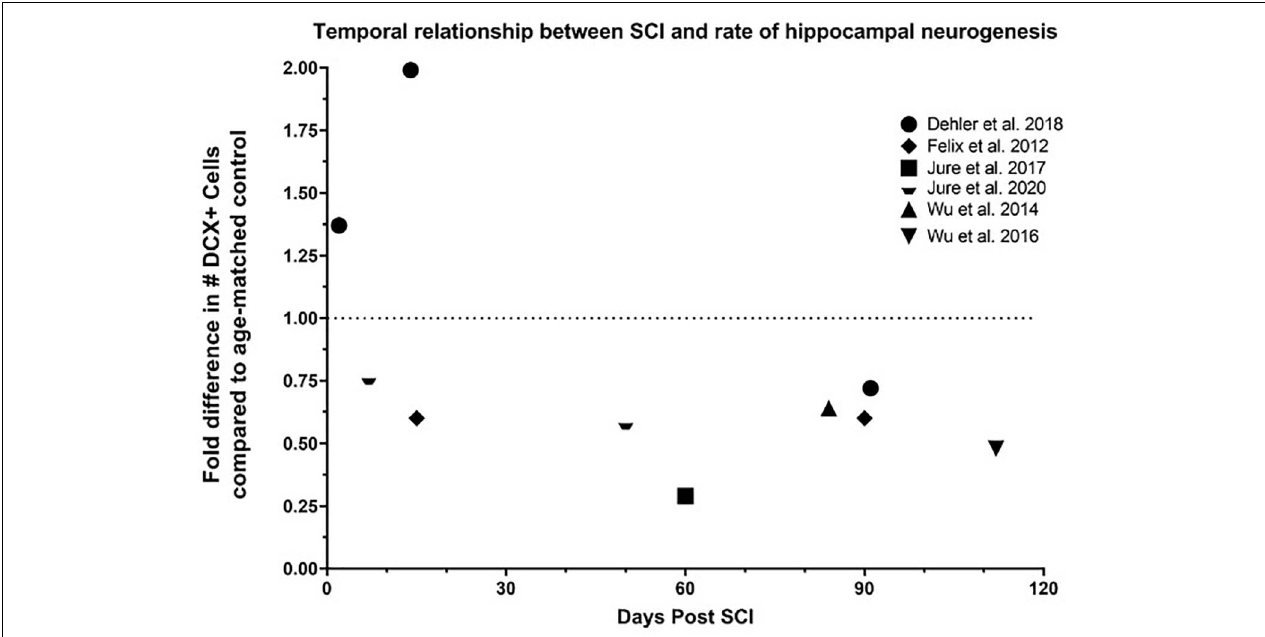
FIGURE 2 | Temporal relationship between SCI and rate of hippocampal neurogenesis. Dehler et al. presented a 37% increase 2 days post injury (dpi), 99% increase 14 dpi, and 28% decrease 91 dpi in the number of DCX+ neurons in the dentate gyrus in a T8 80% transection model on 12-week-old mice (Dehler et al., 2018). Felix et al. reported a 40% decrease 15 and 90 dpi in the number of BrdU+/DCX+ neurons in the dentate gyrus in a C2 left transection in 16-week-old rats (Felix et al., 2012). Jure et al. illustrated a 71% decrease in the number of DCX+ neurons in the dentate gyrus 60 days after severe T8 compression on 8-week-old rats (Jure et al., 2017), and 24% and 42% decrease in the number of DCX+ neurons in the dentate gyrus 7 and 50 days after moderate T8 compression, respectively, on 8-week-old mice. Wu et al. demonstrated a 36% and 52% reduction in the number of DCX+ neurons in the dentate gyrus 84 and 112 days after a moderate T9 contusion in 20-26g mice, respectively (Wu et al., 2014, 2016). TABLE 1 | Relationship between spinal cord injury (SCI) and rate of hippocampal neurogenesis from different sources. Source SCI Type Animal Age Effect (DPI) T8 80% Transection Female Mouse